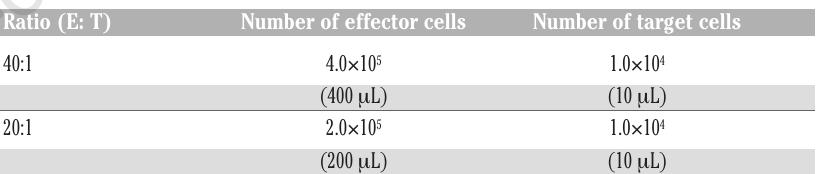
Table 2. Effector and target cell ratios.